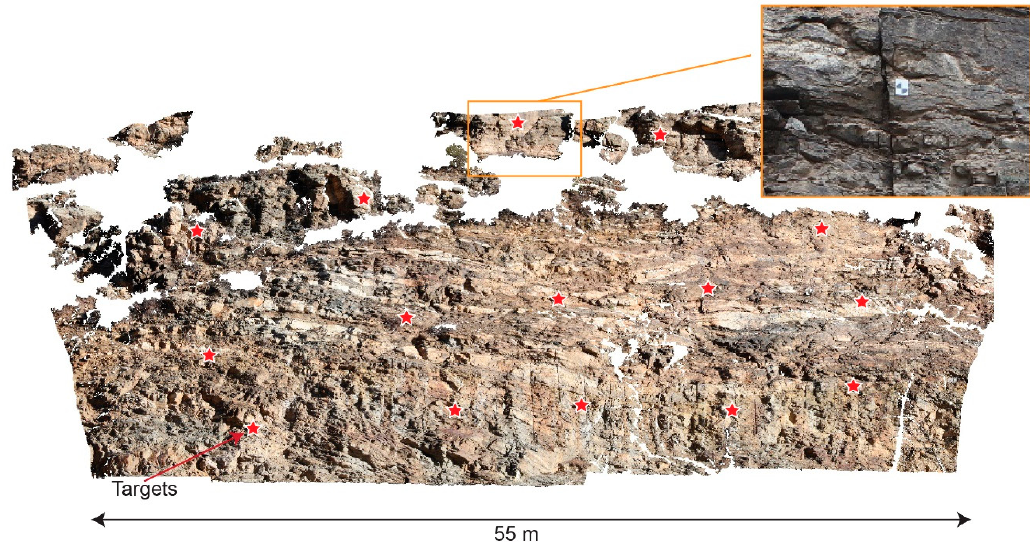
Figure 2. Area of rock slope monitored using the 5-camera monitoring system. For comparison purposes, ground control points (targets) were installed on the monitored area (red stars and inset image).